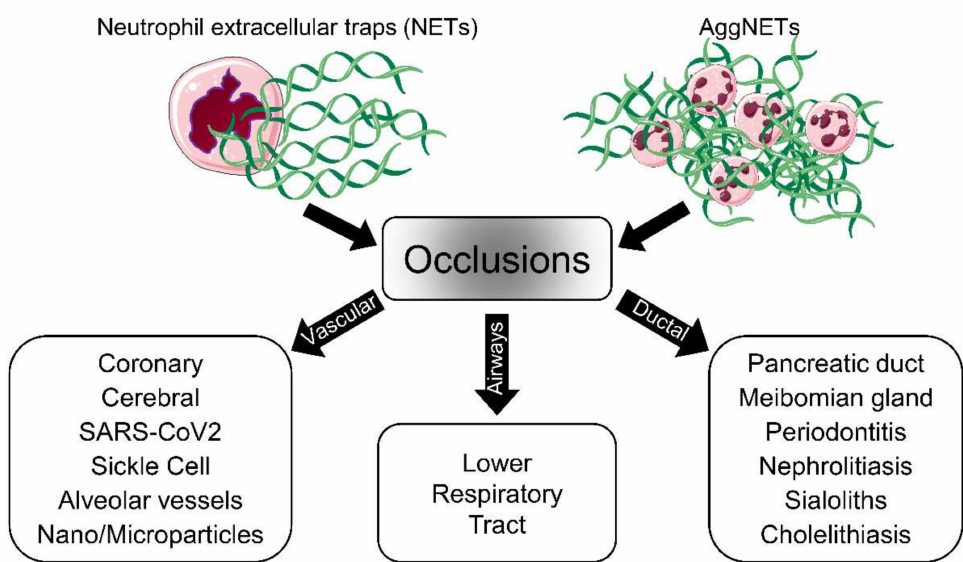
Figure 2. Schematic representation of aggNETs-driven pathologies. The neutrophils, as a first line of defense, eject NETs when they encounter foreign agents. Single or aggregated NETs might cause, under certain conditions, the obstruction of the flow of body fluids and, consequently, disease. The pathology depends on the site of occlusion; vascular NETs formation is associated with both canonical and noncanonical thrombogenesis in various diseases. The accumulation of AggNETs in the lower respiratory tract has been detected in cystic fibrosis patients. Exocrine gland obstruction has been observed in the pancreas and Meibomian and salivary glands. Large organs like the liver and kidneys can also be affected by the accumulation of NETs. The cartoons were modified from https://smart.servier.com accessed on 20 August 2021 in compliance with the terms of the Creative Commons Attribution 3.0 Unported License (CC BY